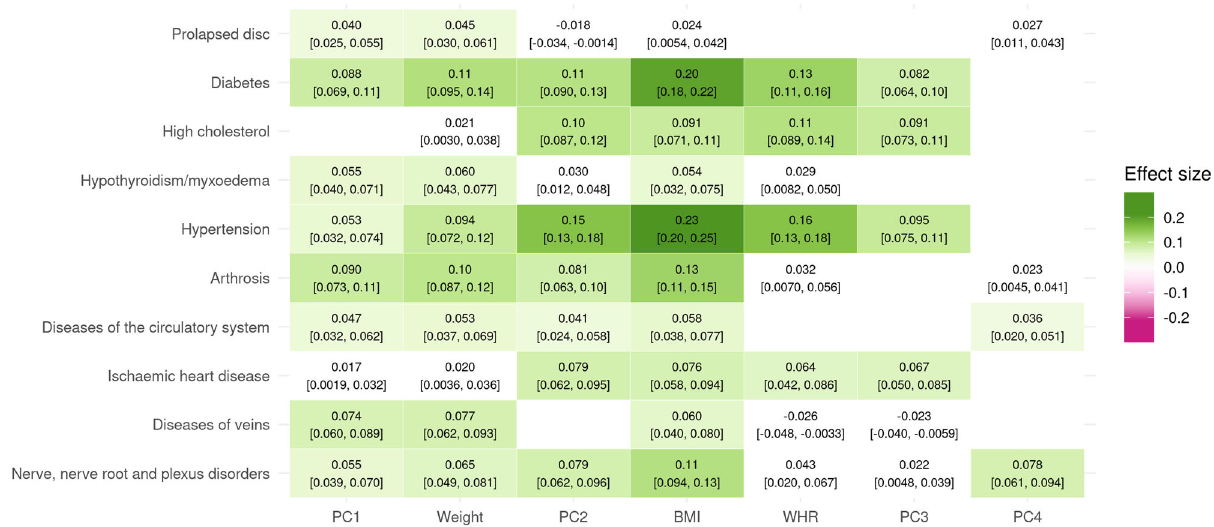
Fig. 4 Single and composite traits increase the risk of multiple diseases. Mendelian randomization causal effects of traits and principal components (PCs) on a selection of diseases on a standardized scale. The 95% con fi dence interval of the effect is indicated in brackets. Effects that were not signi fi cant at the Bonferroni-corrected threshold ( p < 4.3 × 10 − 5 ) are colored in white. The full list of effects can be found in Supplementary Data 11.